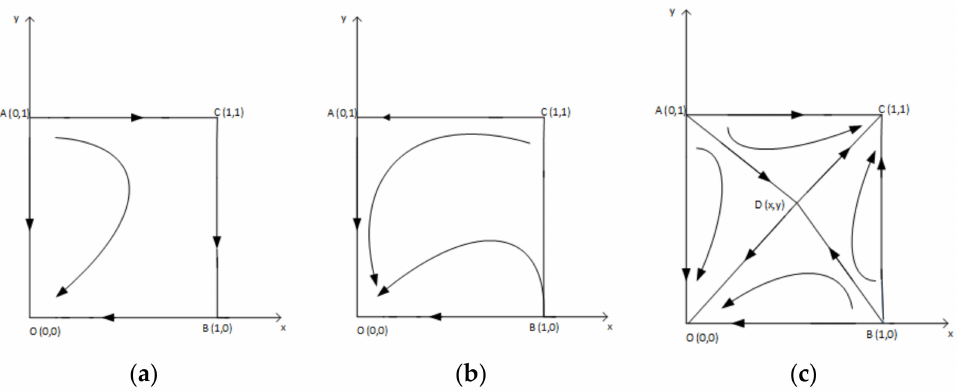
Figure 4. Evolutionary game phase diagrams for active online lending platforms. ( a ) Scenario